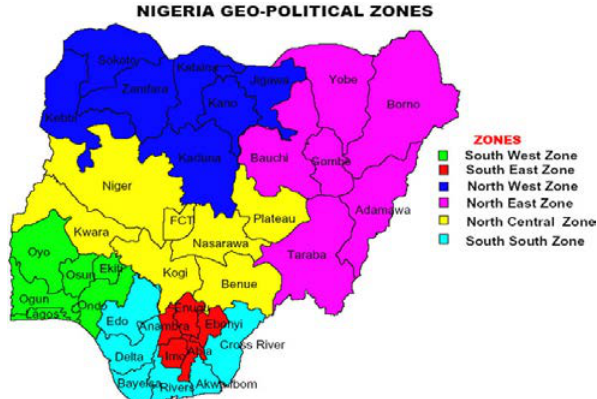
Figure 1. Map of Nigeria. Office of Surveyor General of Nigeria (Babalola et al.